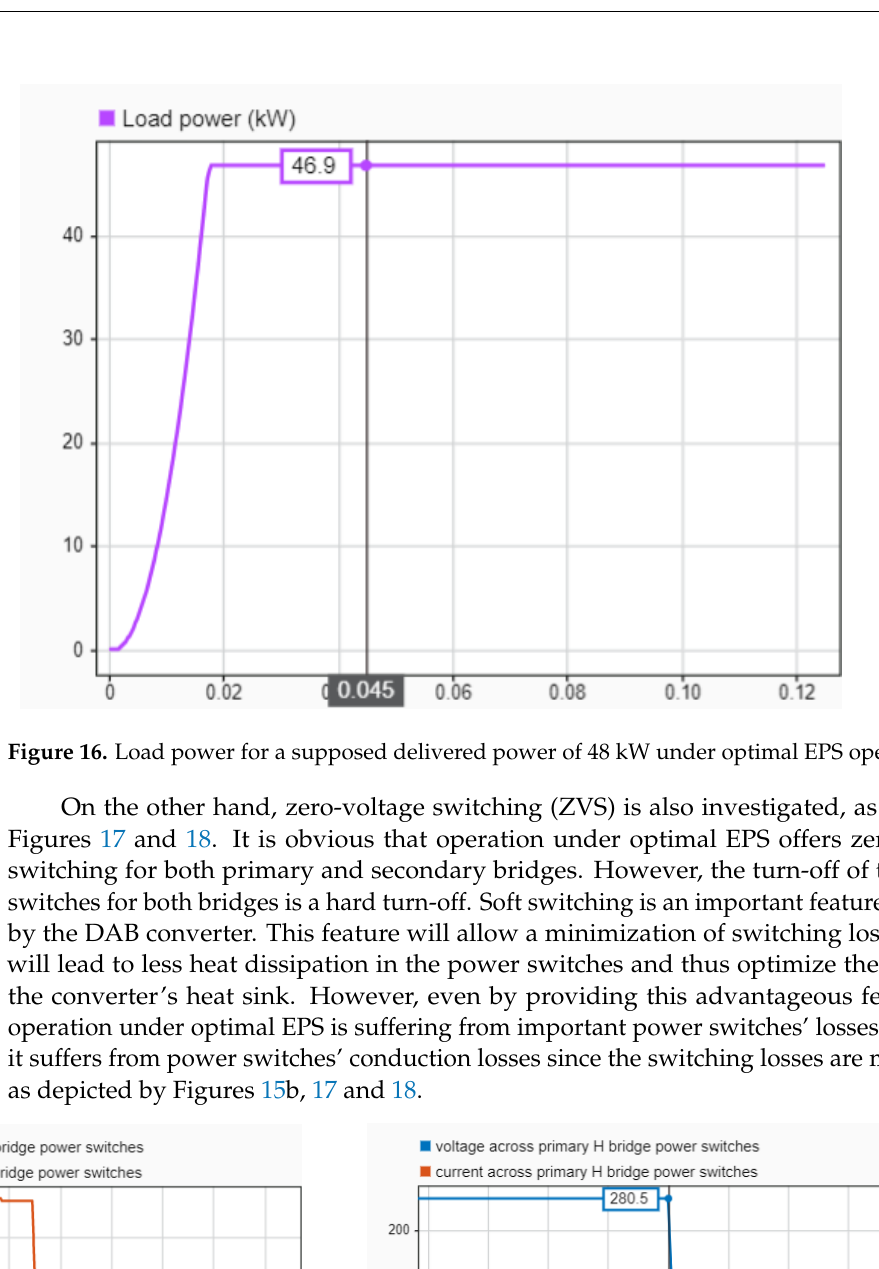
Figure 16. Load power for a supposed delivered power of 48 kW under optimal EPS operation.